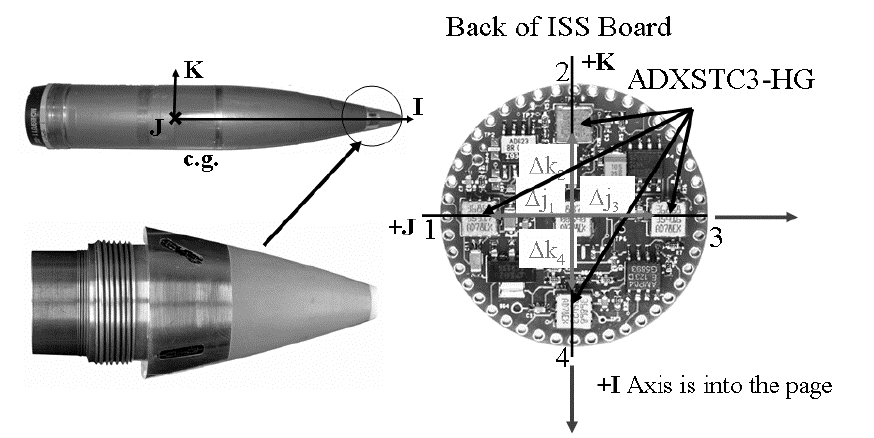
Fig. 5. DFuze and ISS with ADXSTC3-HG accelerometers showing the coordinate